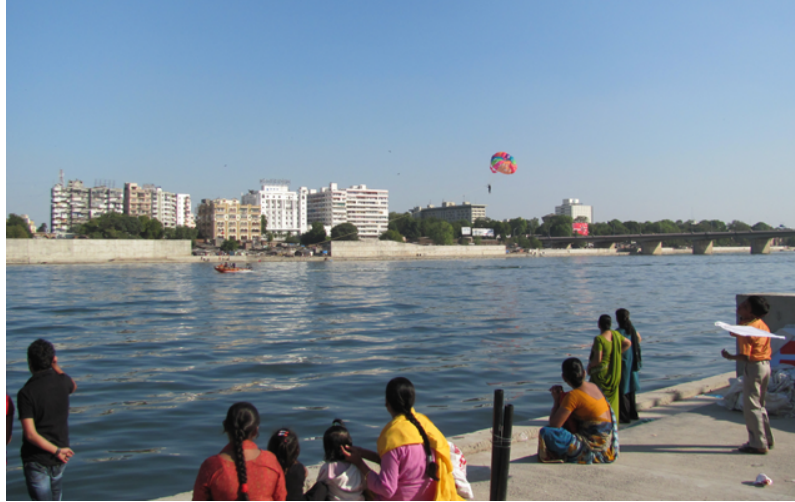
Former slum dwellers on the western side of the Sabarmati riverfront under com- pletion, while touristic activities start taking place along the river filled with water diverted from the Narmada canal (photo: Gloria Pessina,